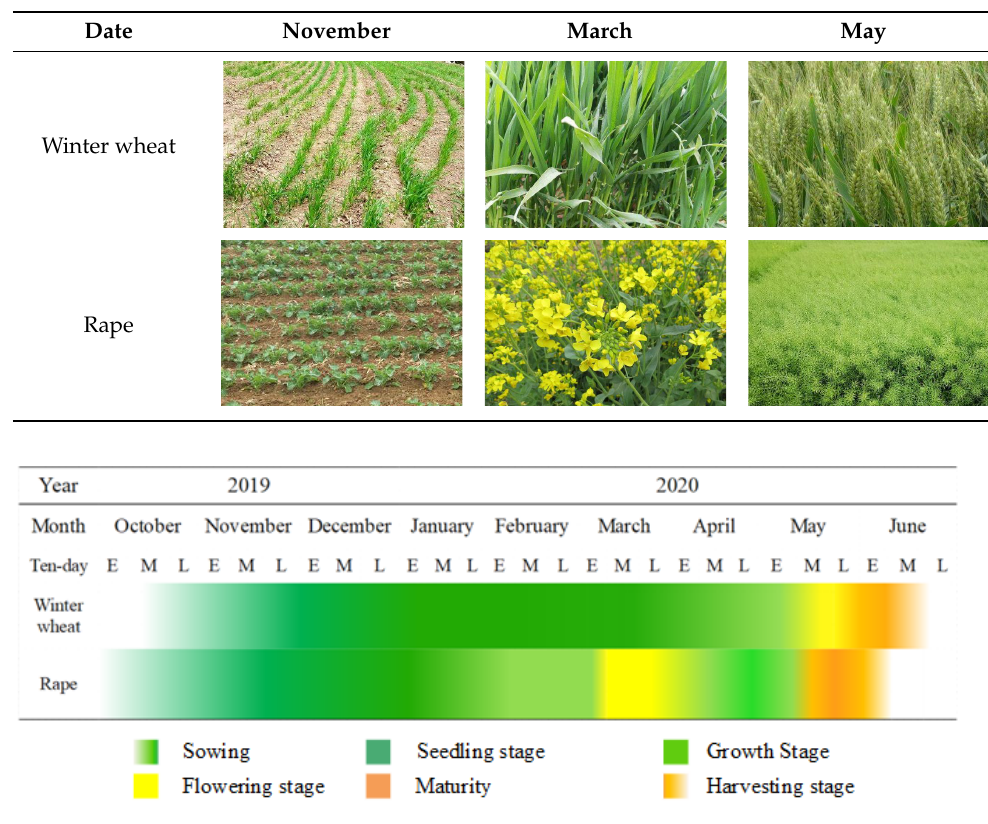
Figure 2. Corresponding phenological calendars of winter wheat and rape.